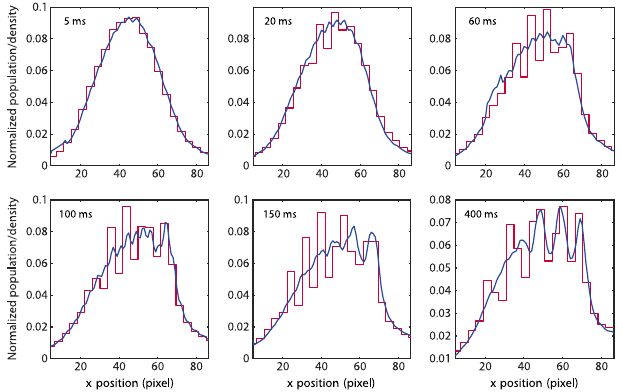
FIG. 11. Spontaneous symmetry breaking and pinning. Long- term dynamics of the density waves illustrated by the populations integrated along the columns. Exemplary single-shot profiles (red line) show the density-wave formation while the absence of a density wave in the average profile (blue line) for early times confirms the spontaneous nature of the symmetry breaking. The average profile is continuous due to the varying lattice phases of the individual images. For later times, the average profile develops density waves as well, indicating the onset of pinning, which we attribute to